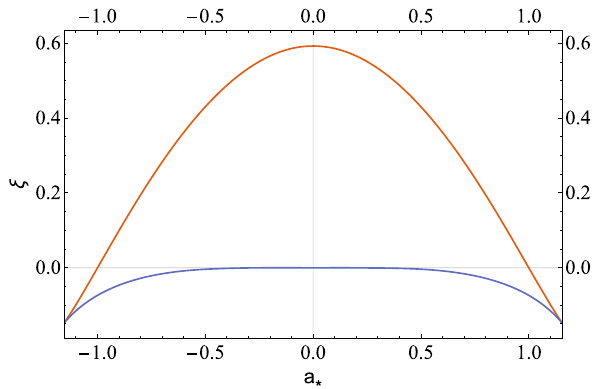
Fig. 1 ξ + (orange curve) and ξ − (blue curve) as a function of the spin parameter a ∗ . Black holes exist for ξ − < ξ < ξ + , while for ξ < ξ − and ξ > ξ + we have naked